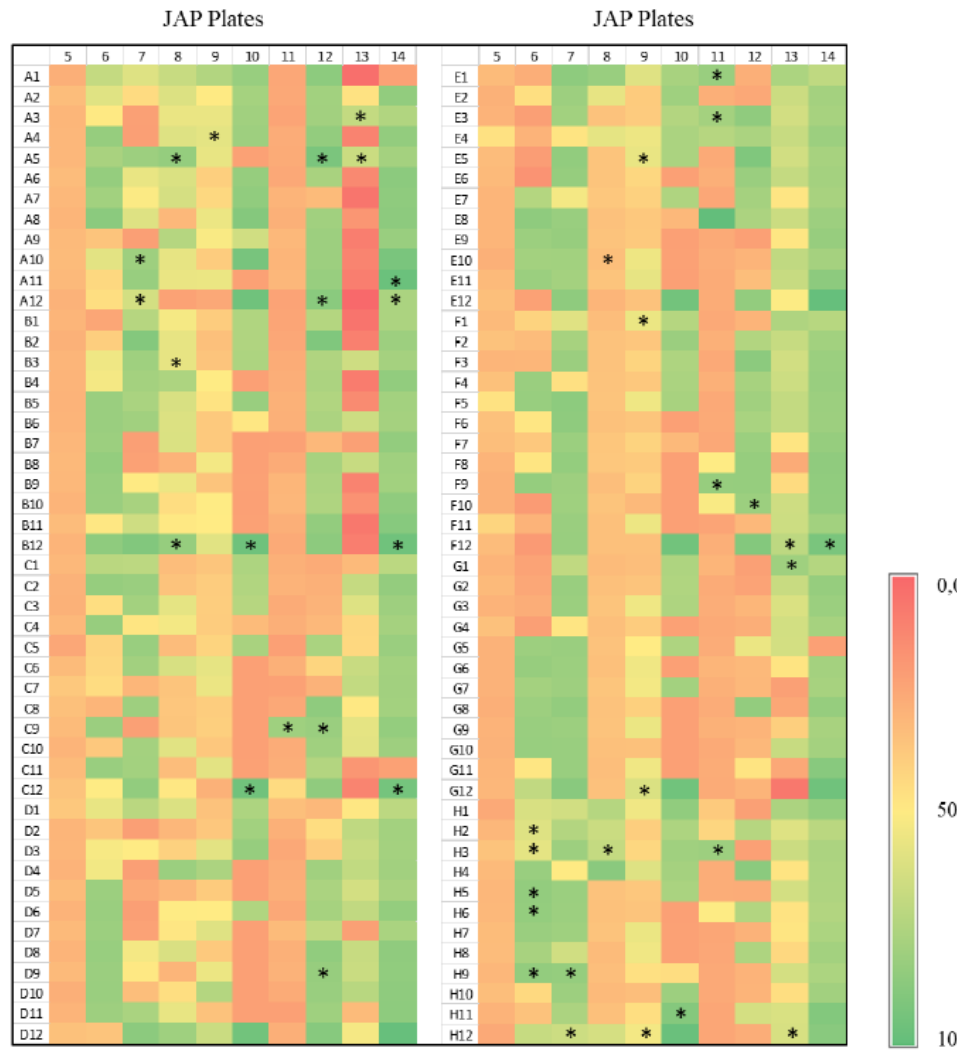
Figure 2. Heat Map showing the growth score of the 960 yeast strains screened on defined medium supplemented with xylose after 120 h. The lines represent the yeast strains code in each plate, whereas the columns the plate numbers. All the values were normalized with the highest growth (OD 600 120 h–OD 600 0 h); i.e., 100% equals to OD 600 1.47. The 42 selected yeast strains are indicated by *.